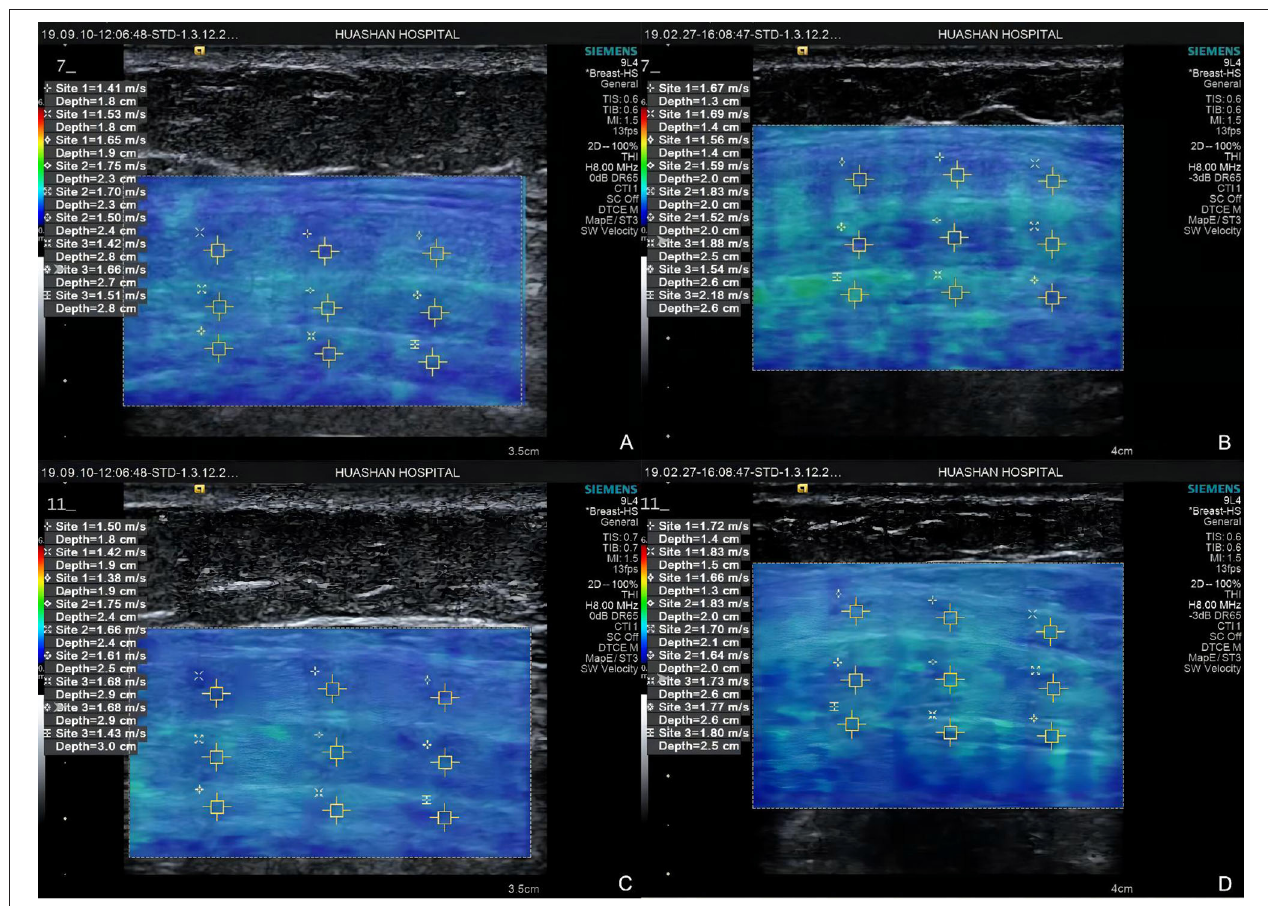
FIGURE 5 | Elastograms at point 1 of Group A (A) external oblique muscle, internal oblique muscle, and transverse abdominis) and Group B (B) external oblique muscle, internal oblique muscle, and transverse abdominis), point 3 of Group A (C) external oblique muscle, internal oblique muscle, and transverse abdominis) and Group B (D) external oblique muscle, internal oblique muscle, and transverse